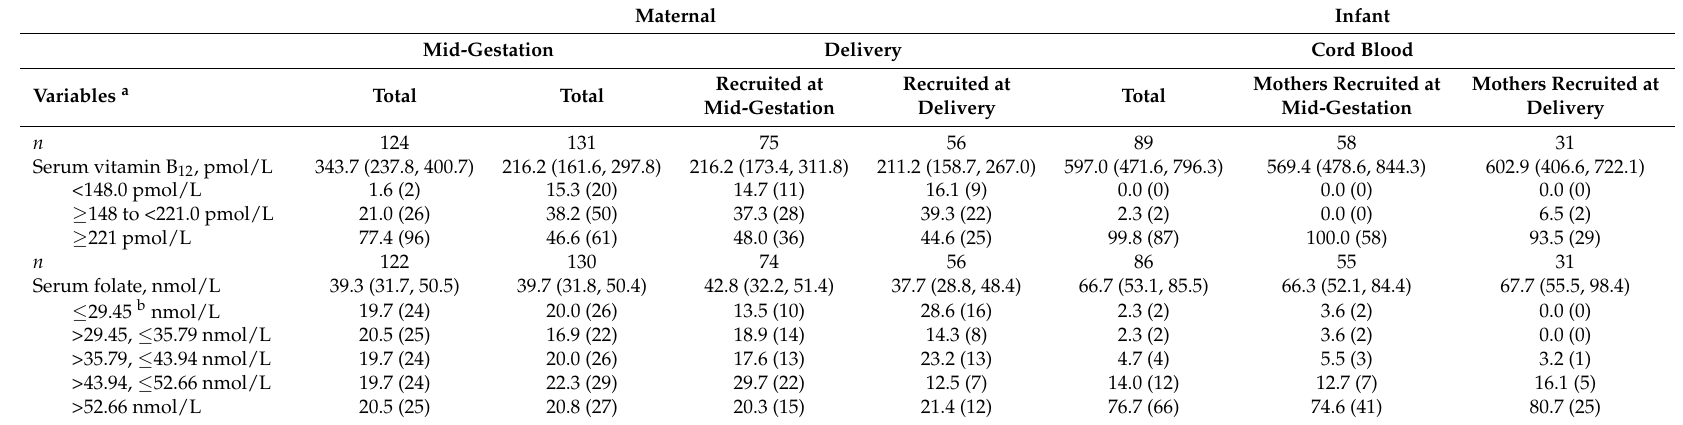
Table 2. Maternal and infant vitamin B 12 and folate